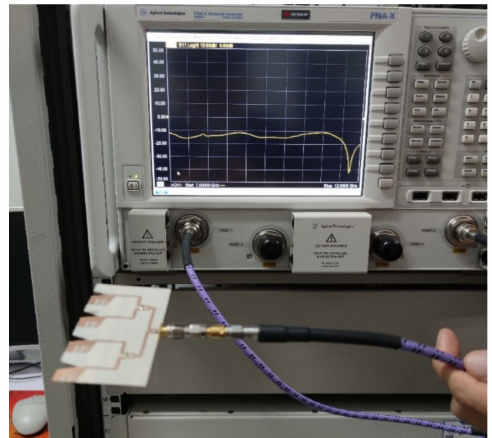
Figure 17. A photograph of the measured |S 11 | scenarios using vector network analyzer Keysight